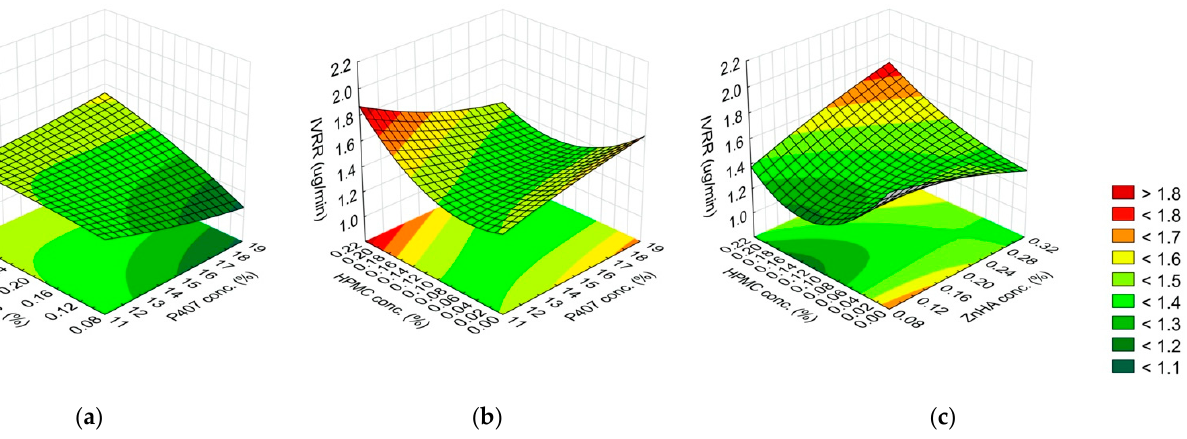
Figure 7. Effect of the composition on the IVRR: ( a ) P407 and ZnHA concentrations, ( b ) P407 and HPMC concentrations, ( c ) ZnHA and HPMC; (the 3rd factor is at 0 level in each case). In the case of the permeability and flux of DXM in the corneal-PAMPA model, the same factors were significant. P407 (L) and its interaction with ZnHA (L) enhance the permeability and the rate of permeation as well. The other significant factors (P407 (Q), the interaction of P407 concentration (L) with HPMC concentration (Q), ZnHA concentration (Q) and HPMC concentration (L) interaction) produced the opposite effect. Increasing the P407 concentration increases the parameters of permeability; however, the negative coefficient of the non-linear factor suggests that the function has a minimum in the investigated concentration range (Figures 8 and 9, Table 4).